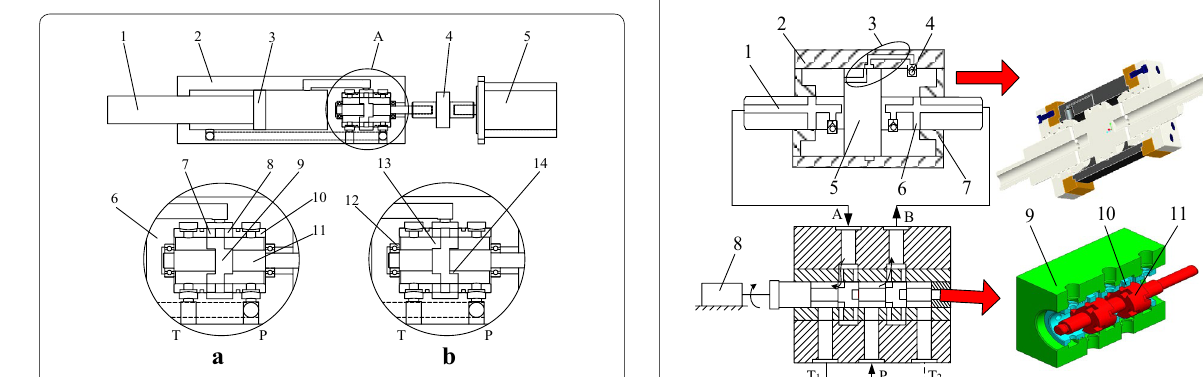
Figure 17 New type of electro-hydraulic vibration equipment with single shoulder spool: a left motion state of the hydraulic cylinder; b right motion state of the hydraulic cylinder. 1. Piston rod; 2. Housing; 3. Piston; 4. Coupling; 5. Step motor; 6. Baffle; 7. First valve sleeve window; 8. Second valve sleeve window; 9. Shoulder; 10. Valve sleeve; 11. Single shoulder spool; 12. Bearing; 13. First groove; 14. Second groove; A: Local structure; P: Oil supply port; T: Oil return port